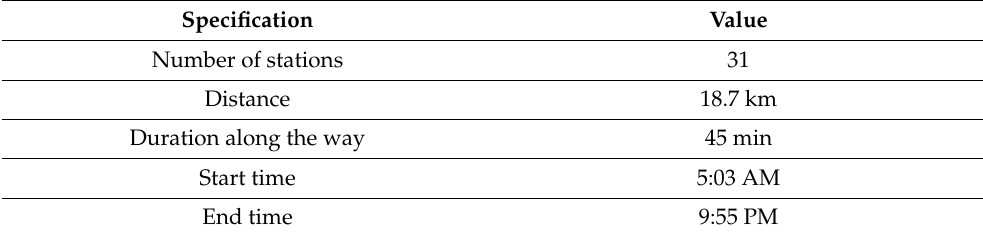
Table 1. The specification of line 1 of Tehran